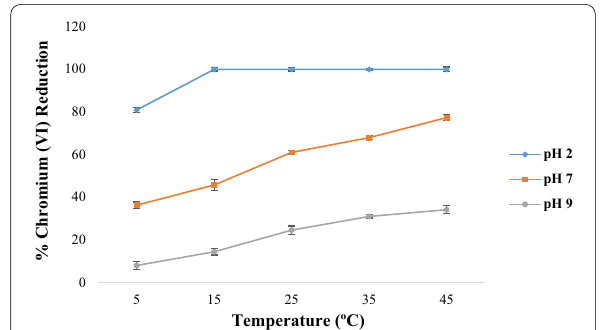
Fig. 6 Effect of temperature on hexavalent chromium reduction by Tamarindus indica methanol leaves extract. (Extract concentration 1 mg/ml, chromium concentration = pH 2.0, 7.0 and 9.0, time 30 min) = =